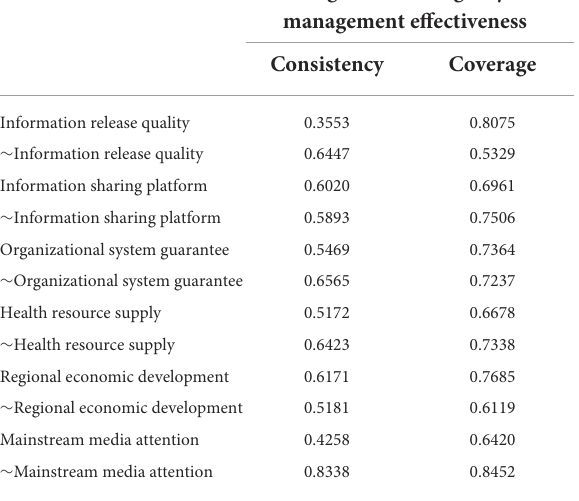
TABLE 4 Configuration analysis of high-level emergency management effectiveness. Configuration